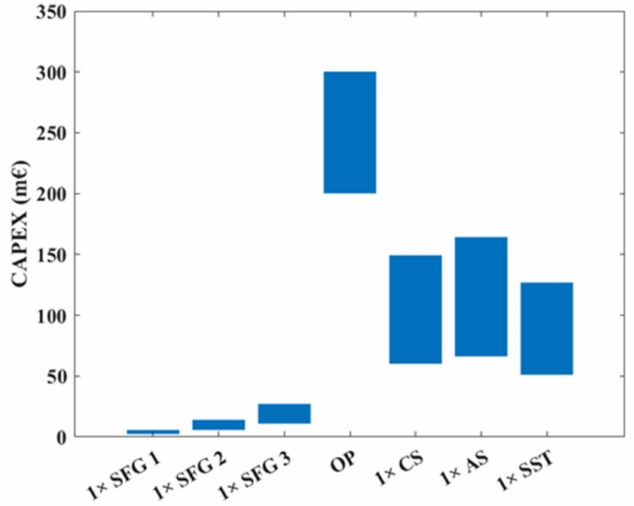
Figure 8. Capital expenditure